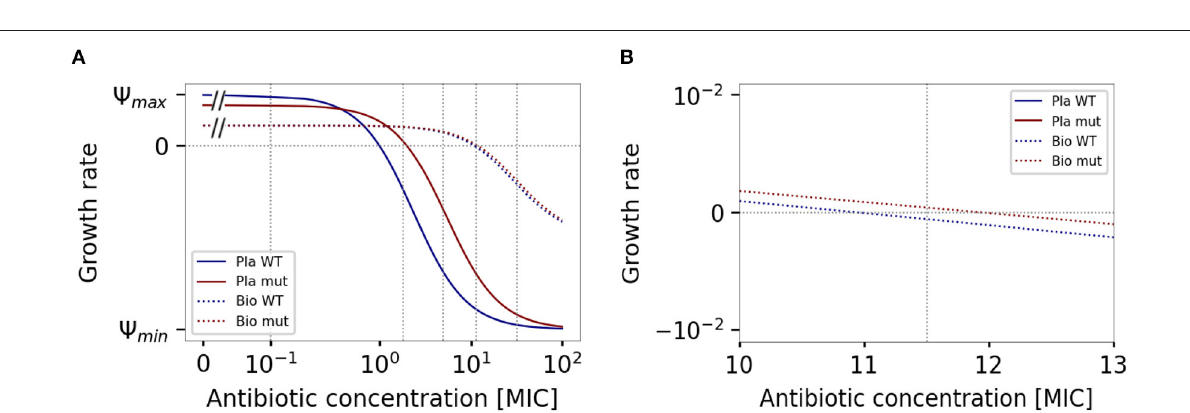
FIGURE 3 | Simplified scheme of the model. Genotypes and lifestyles determine the phenotypes—the pharmacodynamic curve of each strain. The experiment setup defines the drug concentration (environment), which, together with the phenotype, determines each strain’s growth rate and, subsequently, population size. Blue and green circles represent the sizes of the wild type and the mutant populations, respectively.